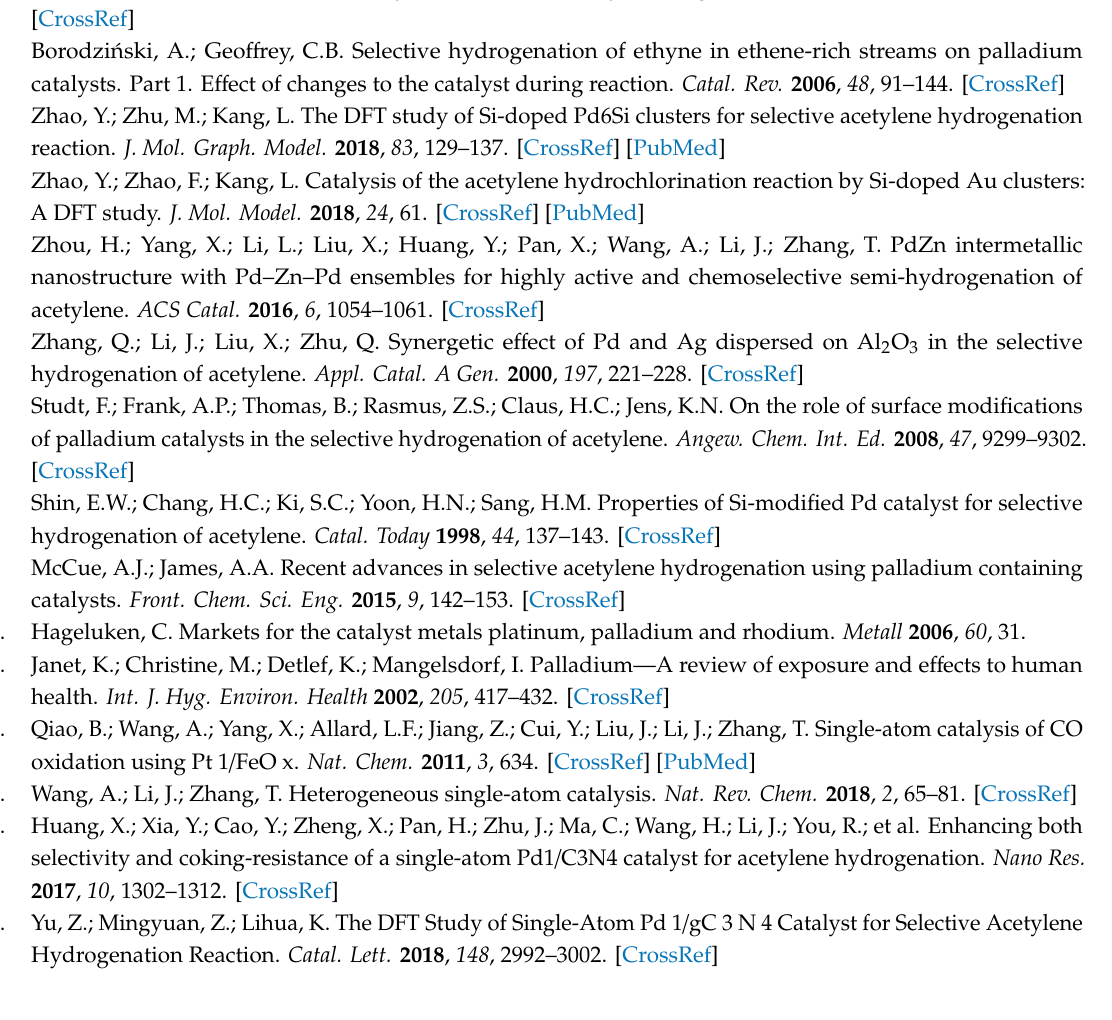
Table S15. The Cartesian coordinates of TS3 on B12N11Ni cluster, Table S16. The Cartesian coordinates of IM3 on B12N11Ni cluster, Table S17. The Cartesian coordinates of CO2 on B12N11Ni cluster, Table S18. The Cartesian coordinates of TS1 on B12N11Ni cluster, Table S19. The Cartesian coordinates of IM1 on B12N11Ni cluster, Table S20. The Cartesian coordinates of TS2 on B12N11Ni cluster, Table S21. The Cartesian coordinates of IM2 on B12N11Ni cluster, Table S22. The Cartesian coordinates of IM3 on B12N11Ni cluster, Table S23. The Cartesian coordinates of TS3 on B12N11Ni cluster, Table S24. The Cartesian coordinates of IM4 on B12N11Ni cluster, Table S25. The Cartesian coordinates of TS4 on B12N11Ni cluster, Table S26. The Cartesian coordinates of IM5 on B12N11Ni cluster, Table S27. The Cartesian coordinates of TS5 on B12N11Ni cluster, Table S28. The Cartesian coordinates of IM6 on B12N11Ni cluster, Table S29. The Cartesian coordinates of TS6 on B12N11Ni cluster, Table S30. The Cartesian coordinates of IM7 on B12N11Ni cluster, Table S31. The Cartesian coordinates of CO on B11N12Ni cluster, Table S32. The Cartesian coordinates of TS1 on B11N12Ni cluster, Table S33. The Cartesian coordinates of IM1 on B11N12Ni cluster, Table S34. The Cartesian coordinates of TS2 on B11N12Ni cluster, Table S35. The Cartesian coordinates of IM2 on B11N12Ni cluster, Table S36. The Cartesian coordinates of IM3 on B11N12Ni cluster, Table S37. The Cartesian coordinates of TS3 on B11N12Ni cluster, Table S38. The Cartesian coordinates of IM4 on B11N12Ni cluster, Table S39. The Cartesian coordinates of TS4 on B11N12Ni cluster, Table S40. The Cartesian coordinates of IM5 on B11N12Ni cluster, Table S41. The Cartesian coordinates of TS5 on B11N12Ni cluster, Table S42. The Cartesian coordinates of IM6 on B11N12Ni